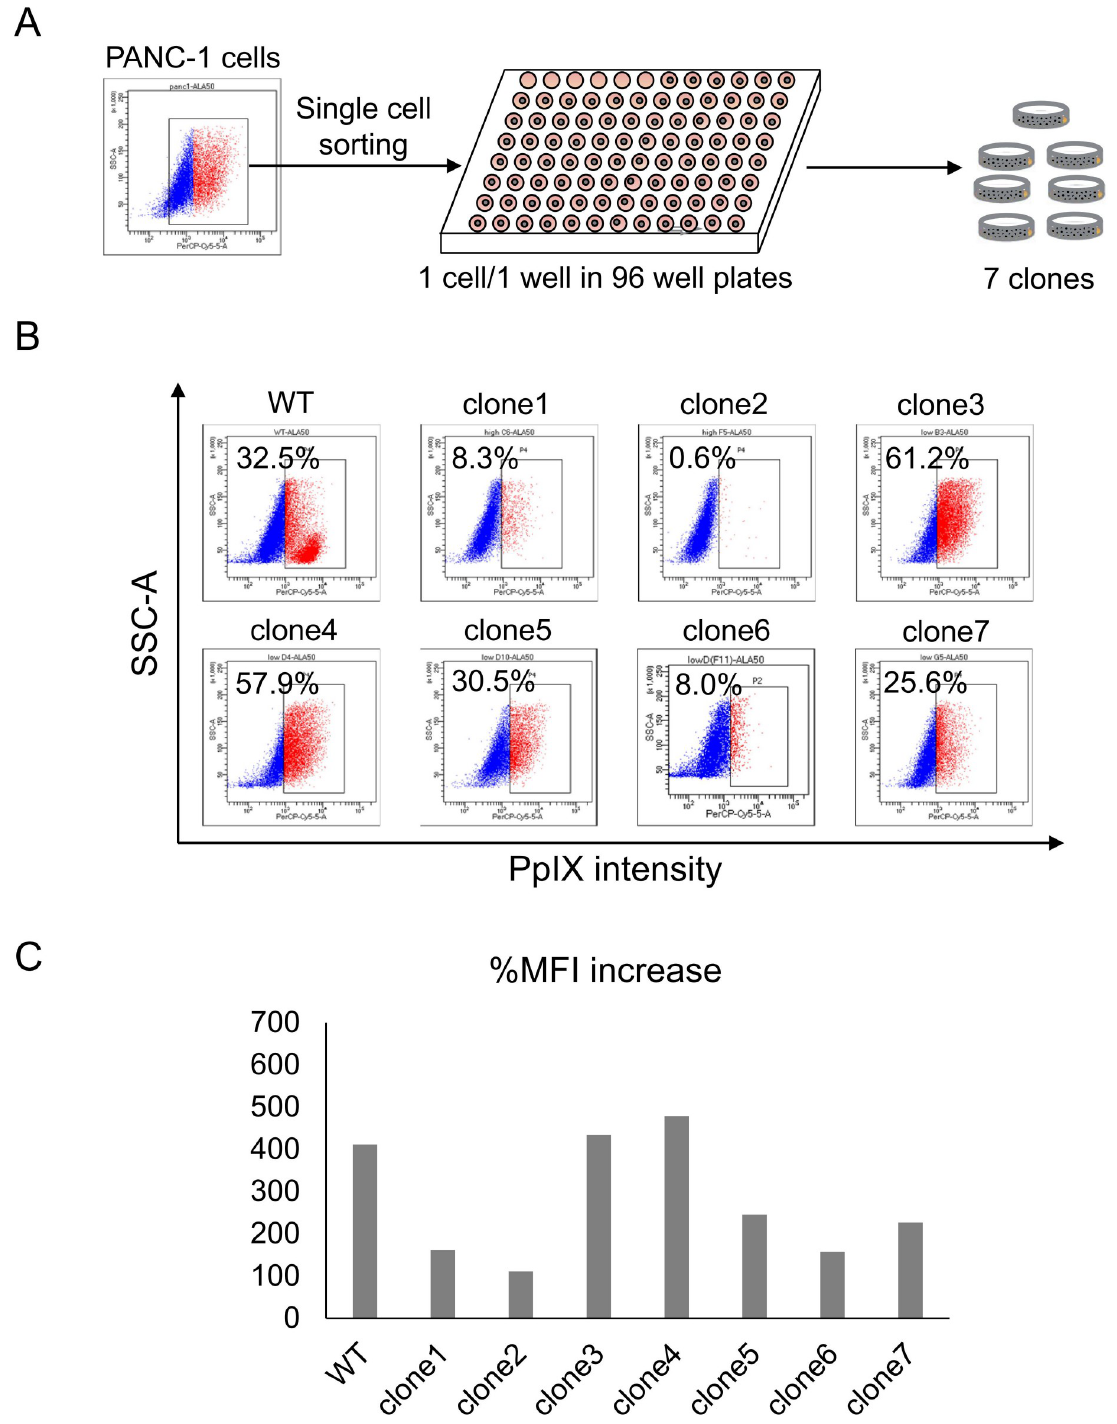
Fig 2. Establishment of PANC-1 clone cells. (A) Schematic summary of single cell sorting of PANC-1 cells. (B) FACS analysis of 5-ALA-stained PANC-1 clone cells. Non-stained cells were used as negative controls. Percentages indicate the positive rates of PpIX intensity. (C) Summary of percent mean fluorescent increase (%MFI)